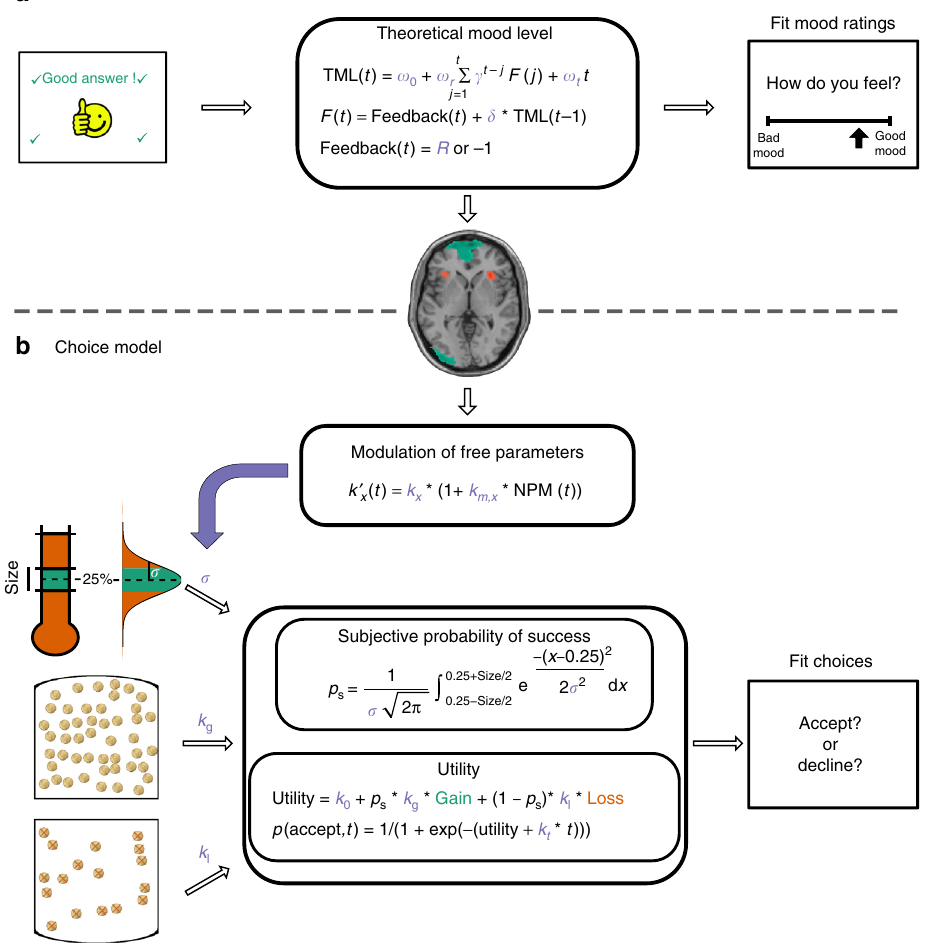
Fig. 2 Computational modeling. The fi gure illustrates the best models that were selected using group-level random-effect analyses. a Best mood model. Theoretical mood level (TML) was computed as an integration of quiz feedback, with an exponential decay. This feedback was subjective, as its perception was in return biased by TML, and different for positive and negative feedback. TML was then regressed against fMRI data to identify the neural correlates of mood during the rest period between the quiz and choice tasks. b Best choice model. Baseline activity (at the time of prospect display) in mood-related regions (termed Neural Proxy for Mood, NPM) modulated the free parameters of the choice model. A fi rst parameter was the variance of the subjective distribution of forces produced (parameterized by σ , the width of the Gaussian), which served to calculate the subjective probability of success p s , as the integral of probability distribution within the target window. This probability p s was integrated in the expected utility of the prospect, which had two other free parameters — the weights of potential gain and loss, k g and k l . Acceptance probability was calculated as a sigmoid function (softmax) of expected utility, with a last parameter k t that accounted for a linear drift with